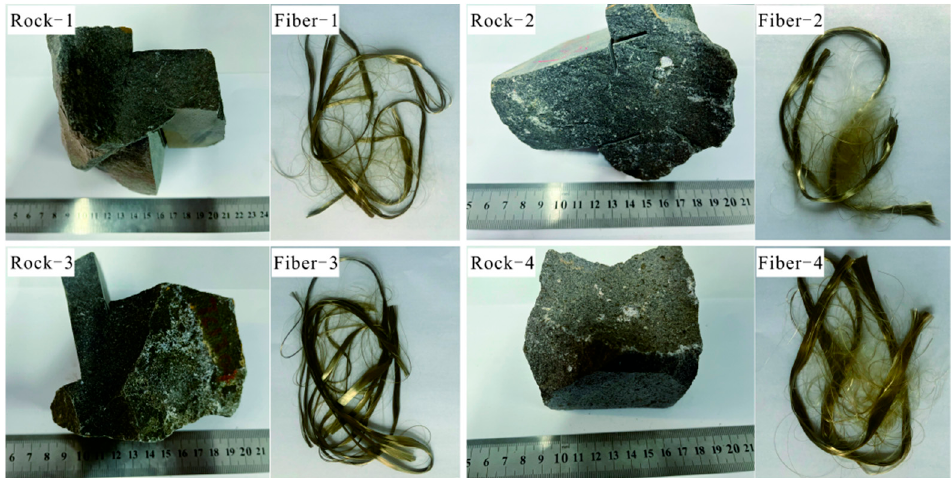
Figure 1. Basalt and corresponding fibers.